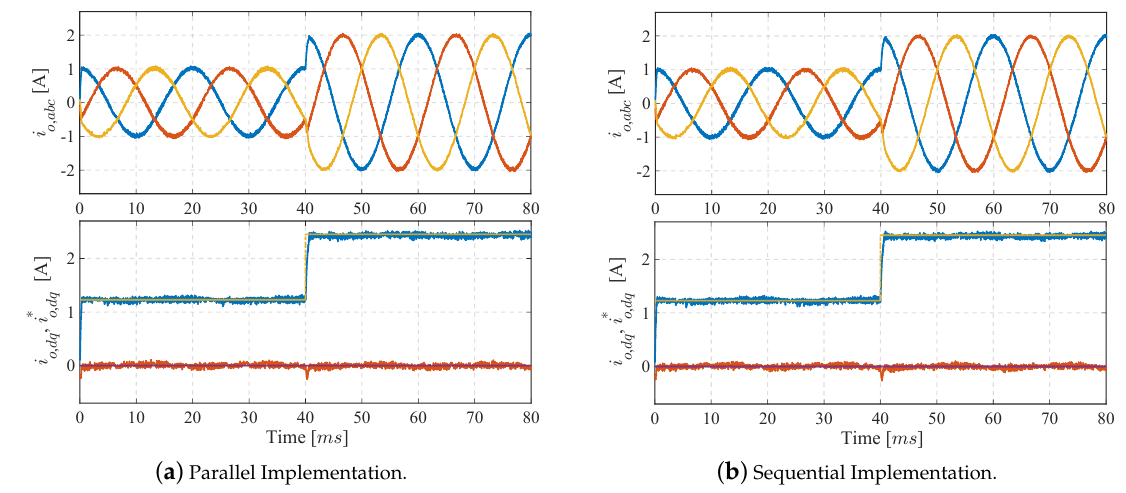
Figure 8. Experimental results: Output currents in abc and dq-frame. At t = 40 ms, the reference amplitude for the abc-frame current changes from 1 A to 2